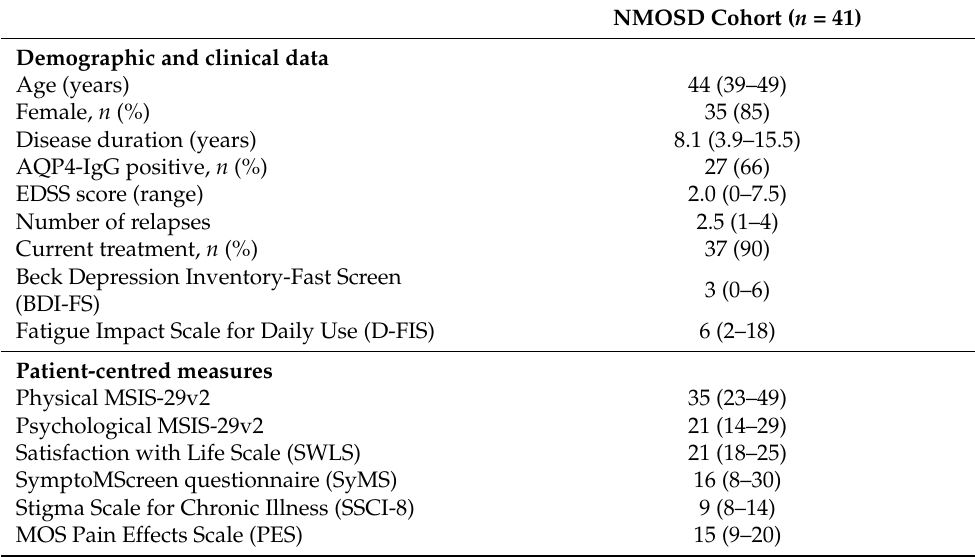
Table 1. Demographic, clinical and patient-centred measures data of the study